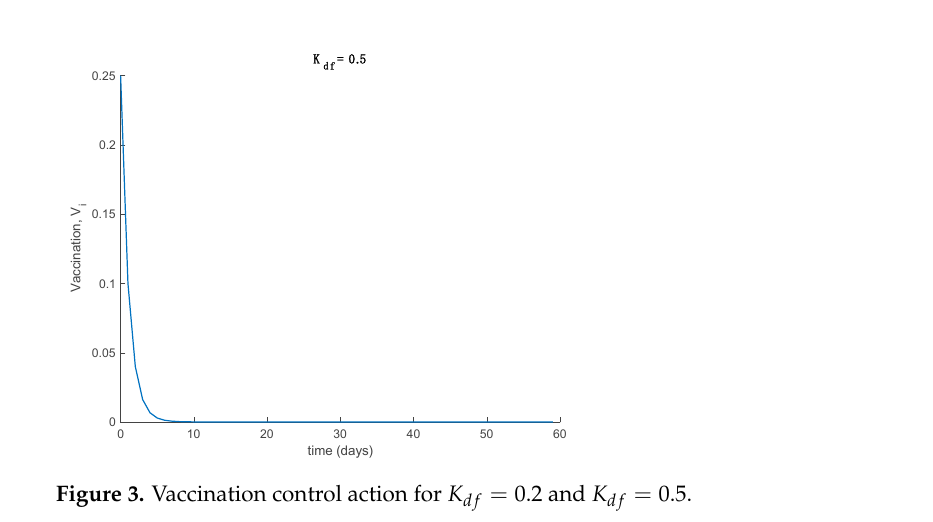
Furthermore, according to Theorem 3, the obtained disease-free equilibrium points